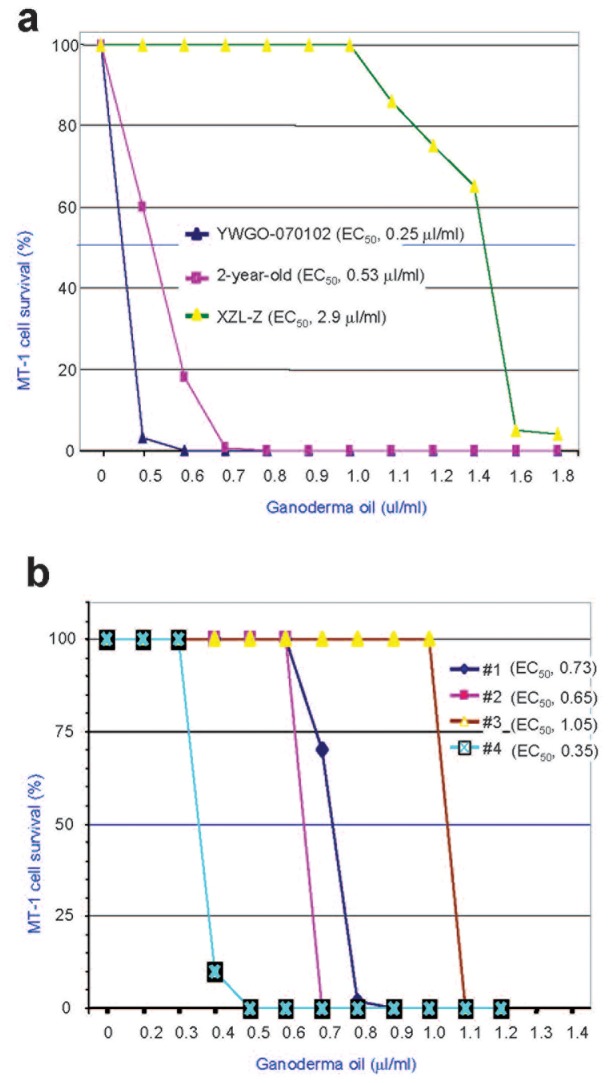
Effects of Ganoderma oil from different sources on tumor cell death.(a) Breast carcinoma cells (MT-1) were treated with Ganoderma oil prepared from the standard protocol (WYGO-070102), 2-year-old (maintained at room temperature) Ganoderma oil prepared from the standard protocol, and a sample of Ganoderma oil obtained from a different source (XZL-Z). Analysis of the half maximal effective concentration (EC50) indicated that the Ganoderma oil prepared from the standard protocol produced the best result in inducing tumor cell death, followed by the 2-year-old product and the sample from a different source. (b) MT-1 cells were treated double-blindly with Ganoderma oil obtained from different sources. EC50 was obtained as indicated.